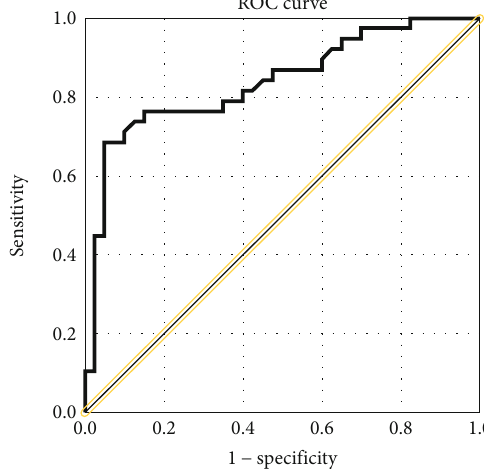
Figure 4: ROC curve analysis of serum sST2 in predicting the e ffi cacy of SLIT. ROC: receiver operating characteristic; sST2: soluble suppressor of tumorigenicity 2; SLIT: sublingual